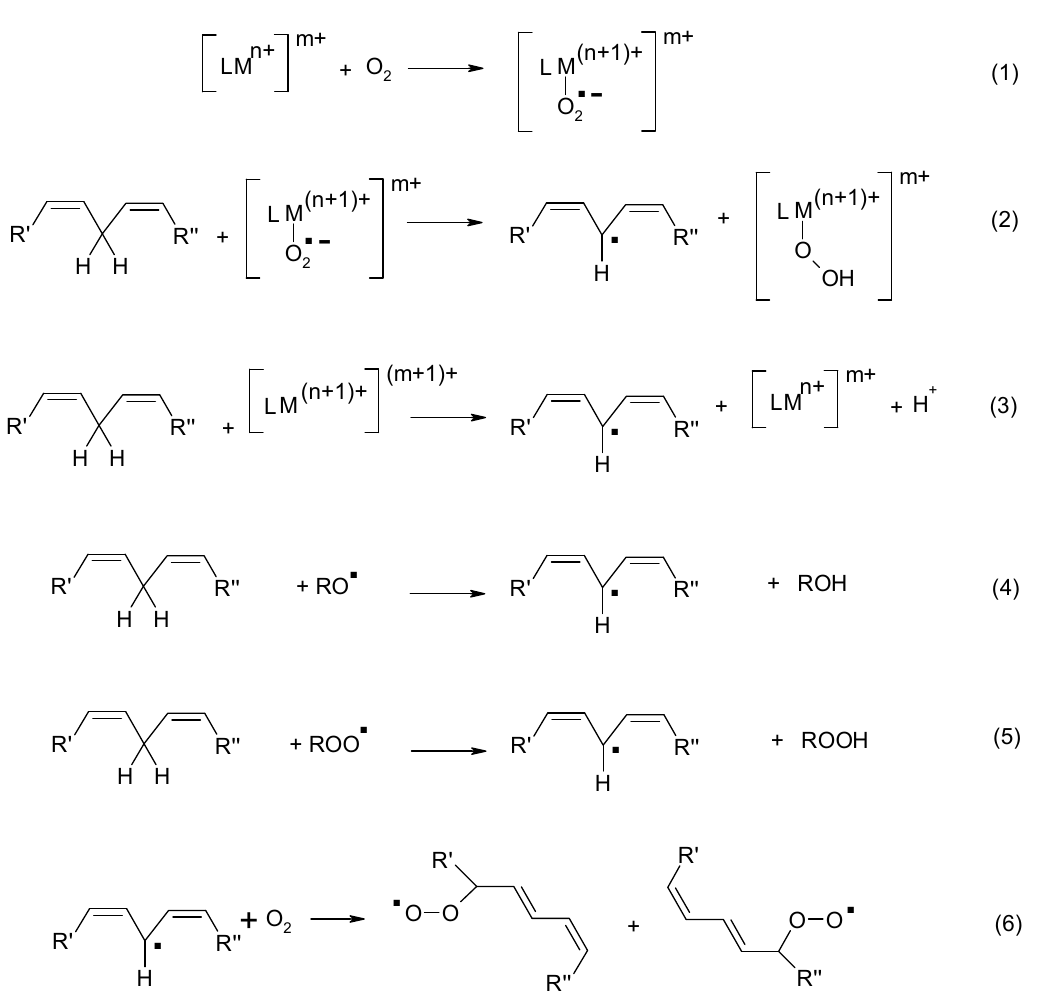
Scheme 1. Examples of reactions during radical curing processes in alkyd resins (L stands for organic ligand bound to metal ion) (Reactions (1)–(6)) [4].